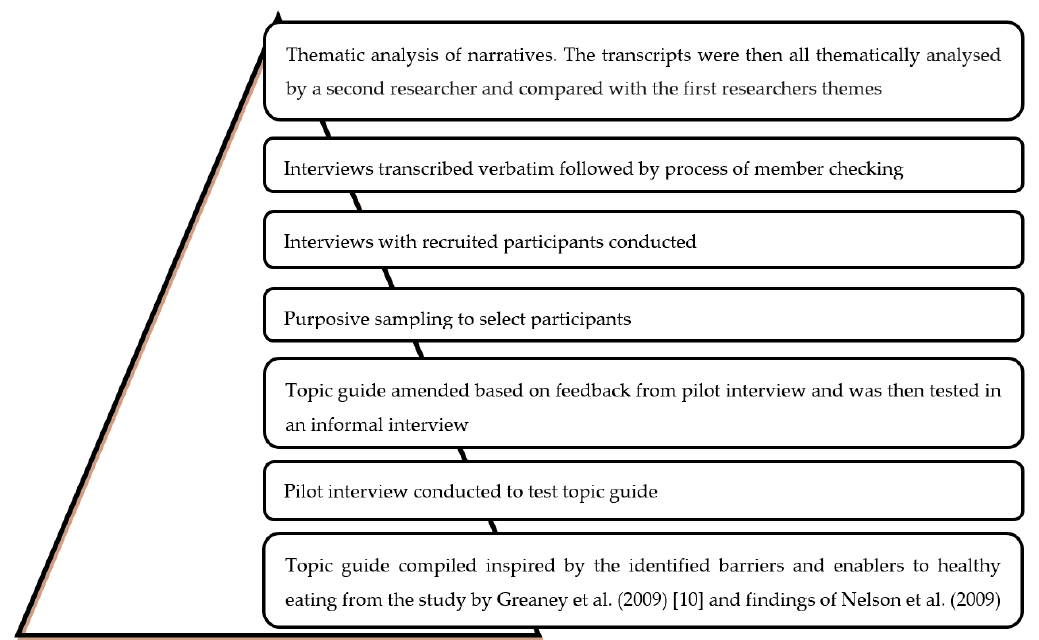
Figure 3. Process undertaken for establishing the topic guide for the semi-structured in-depth